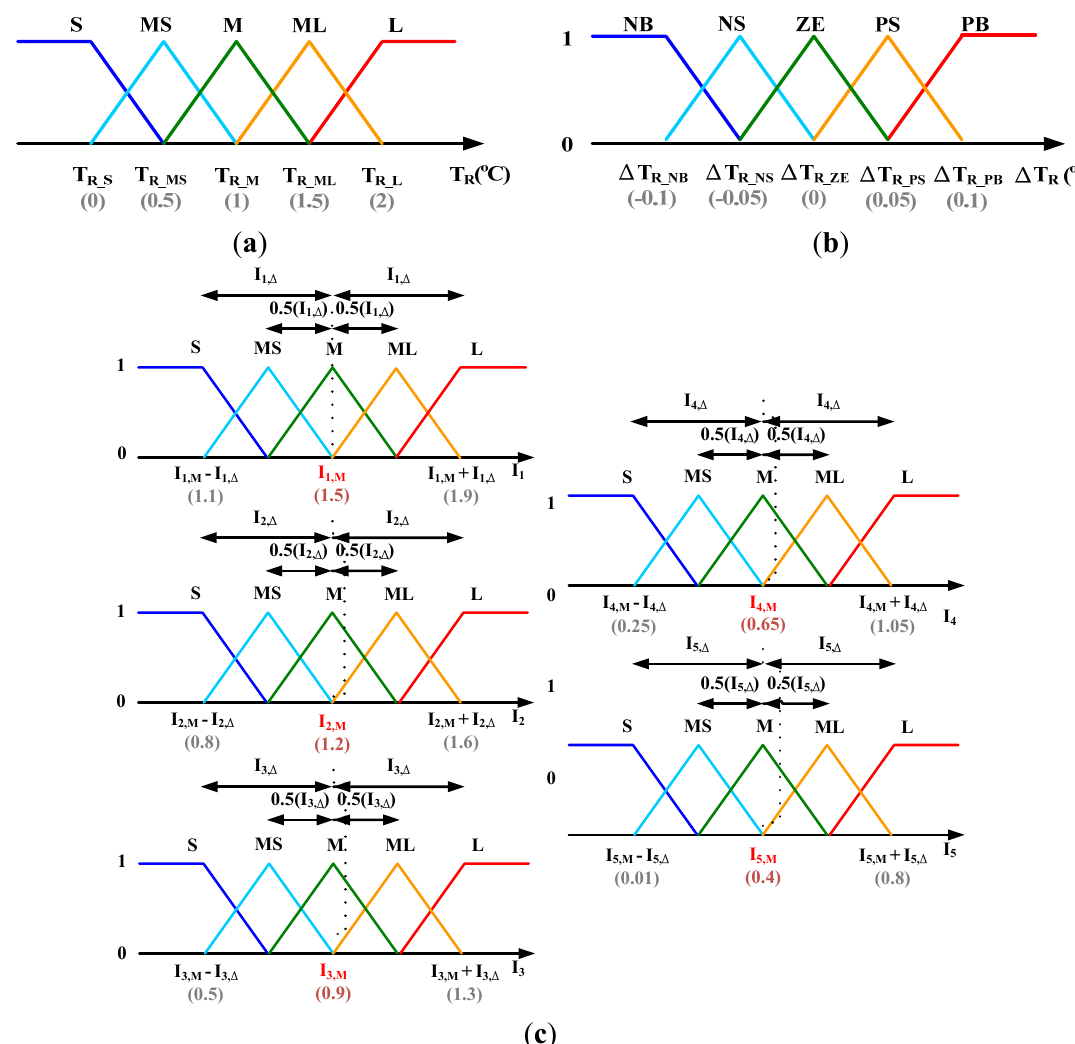
; ( c ) MFs of the output variable I R